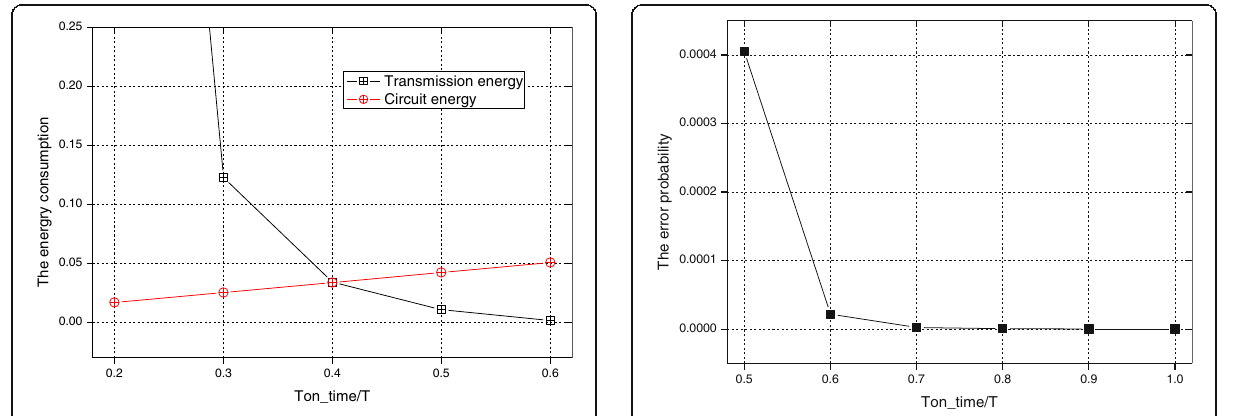
Fig. 4 The energy consumption of transmission and circuit (MPSK) Fig. 5 The bit error rate under MPSK